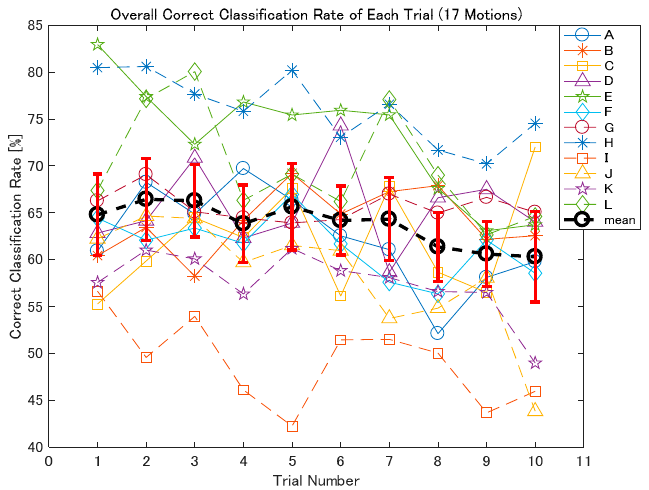
Figure 12. Correct classification rate of 17 voluntary movements of each trial. Note that the correct rates of participant A, B, E and H are from the experiment on day 2 (best classification).